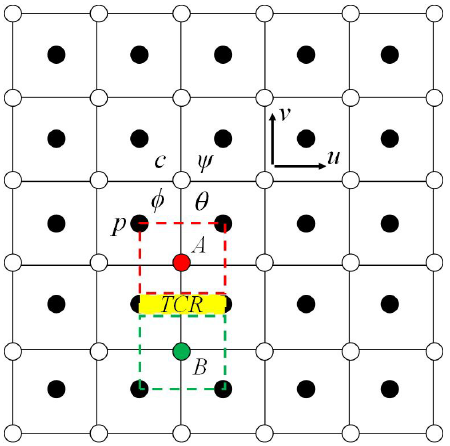
Figure 7. A half-staggered grid. ψ stores other variables such as temperature, and u and v are velocity components in the horizontal and the vertical directions, respectively.